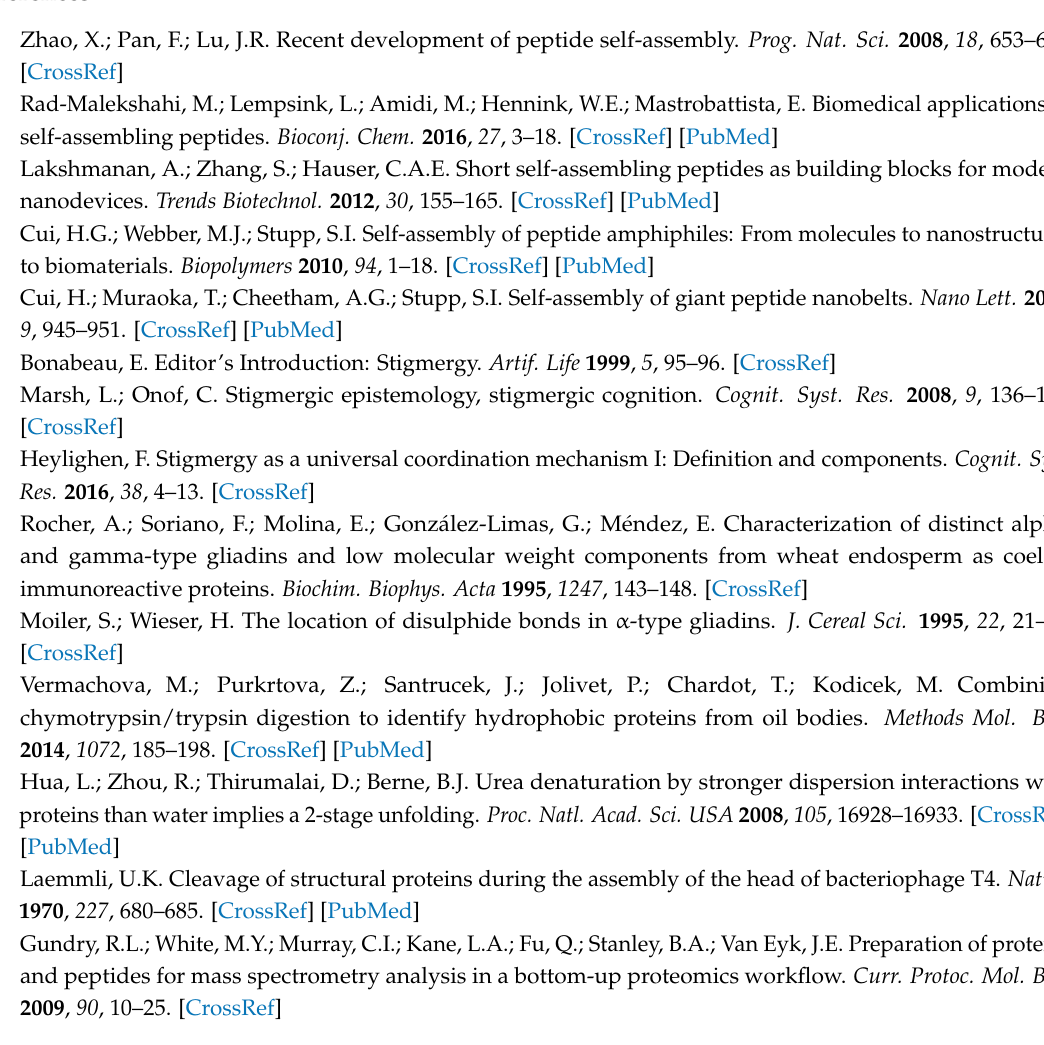
Figure S1: Internal structure of a stigmergic physical agent. Figure S2: Basic architecture of Stigmergy. Figure S3: Schematic representation of stigmergy proceeding by marker-based and sematectonic mechanism. Figure S4: Inverse relation of Symmetry and Organization. Figure S5: Emergence as a Subcategory of Self-Organization. Table S1: Classification of